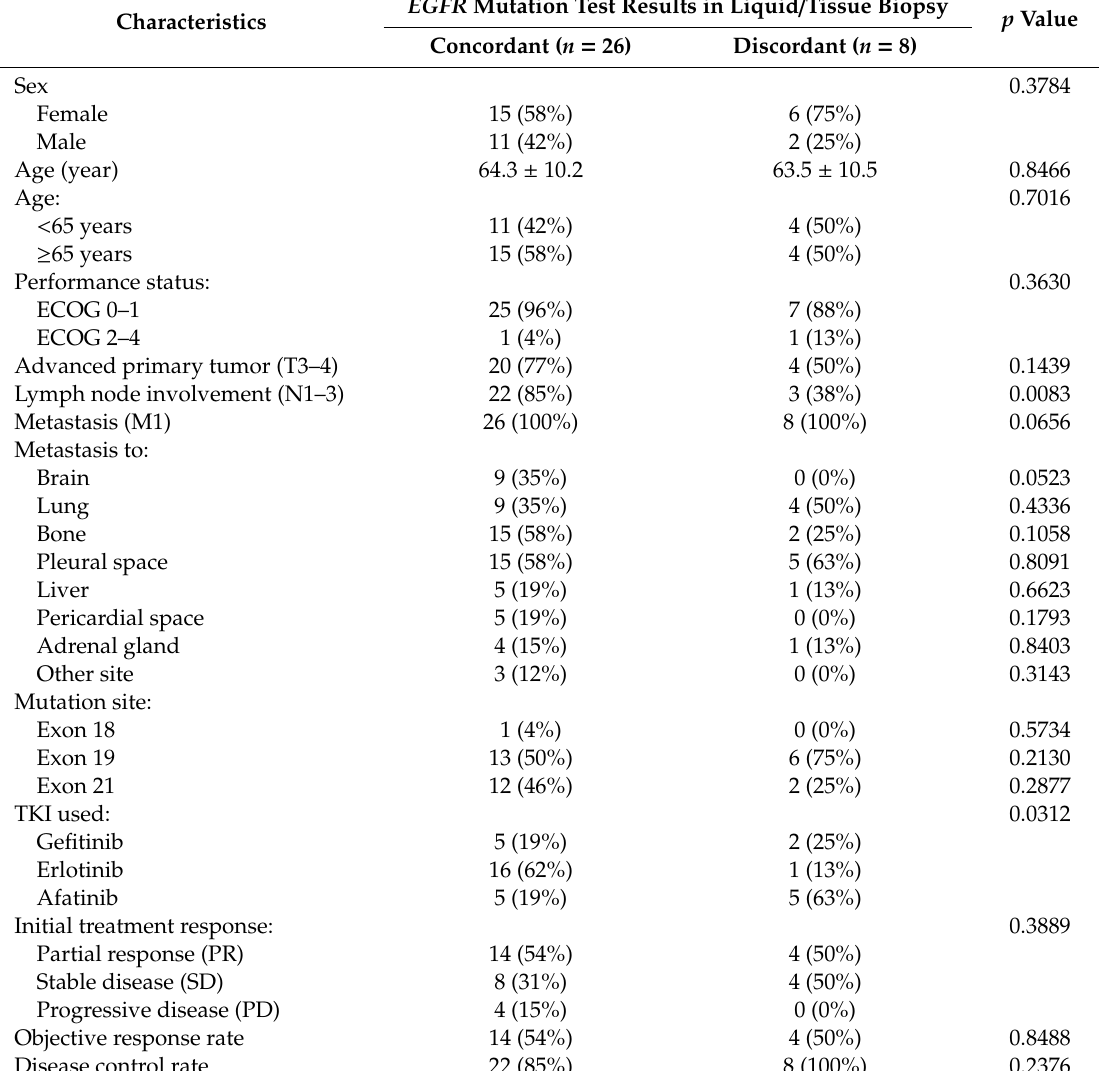
Table A3. Characteristics of the stage IV patients receiving first-line EGFR TKIs (only patients using Qiagen ® EGFR RGQ PCR kit for their tissue